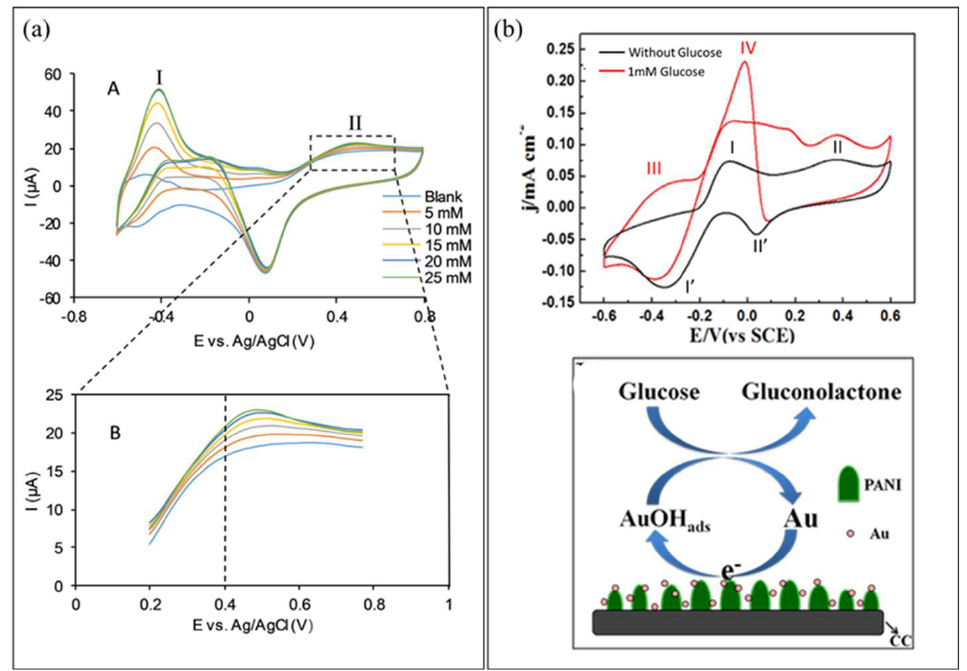
Figure 12. CV of ( a ) nanoporous Pt/SPCE − polyimide-modified electrode in the absence and presence of various glucose concentrations and the magnified area of glucose oxidation with 0.4 V oxidation potential in 0.1 M PBS (pH 7.4) solution. Reprinted with permission from ref. [203]; Copyright 2020 Elsevier. ( b ) AuNP/PANI/carbon cloth-modified electrode in the absence and presence of 1 mM glucose in 0.5 M KOH solution, and the schematic of electrocatalytic glucose mechanism. Reprinted with permission from ref. [209]; Copyright 2017 Elsevier.